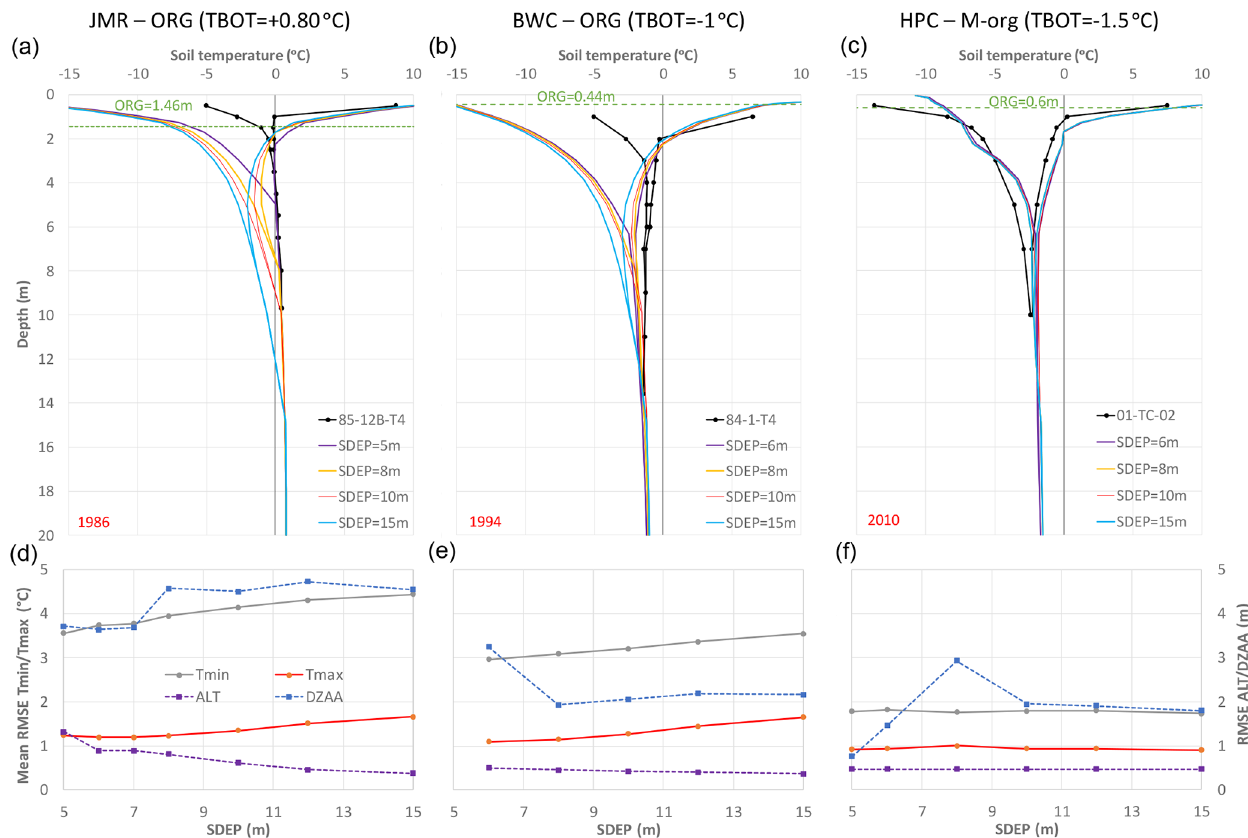
Figure 13. Impact of SDEP on simulated temperature envelopes for a selected year at each study site (a–c) . RMSE for temperature envelopes (Tmax and Tmin), ALT and DZAA (d–f) over the simulation period for the needleleaf forest GRU at each study